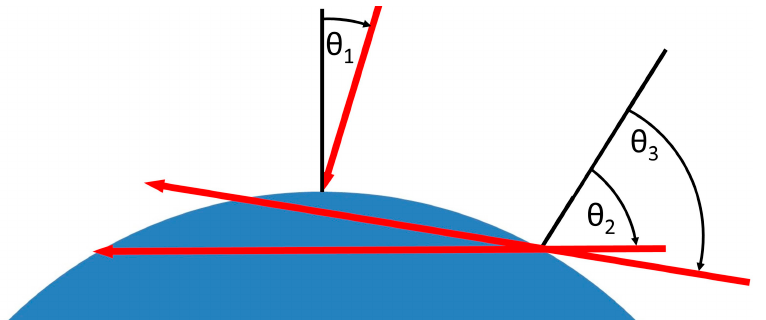
Figure 1. Three MQN trajectories are shown as red arrows, along with their angle of impact θ with respect to the normal surface of an idealized, not to scale, Earth (blue). The trajectory with impact angel θ 1 ≪ 90° is a more common radial impact. Nearly tangential trajectories that transit through Earth are represented by trajectories with impact angles between θ 2 and θ 3. MQNs on a θ 2 trajectory emerge from Earth with negligible velocity after transiting a distance x max , the maximum range of an MQN. MQNs on a θ 3 trajectory emerge from Earth with considerable velocity.